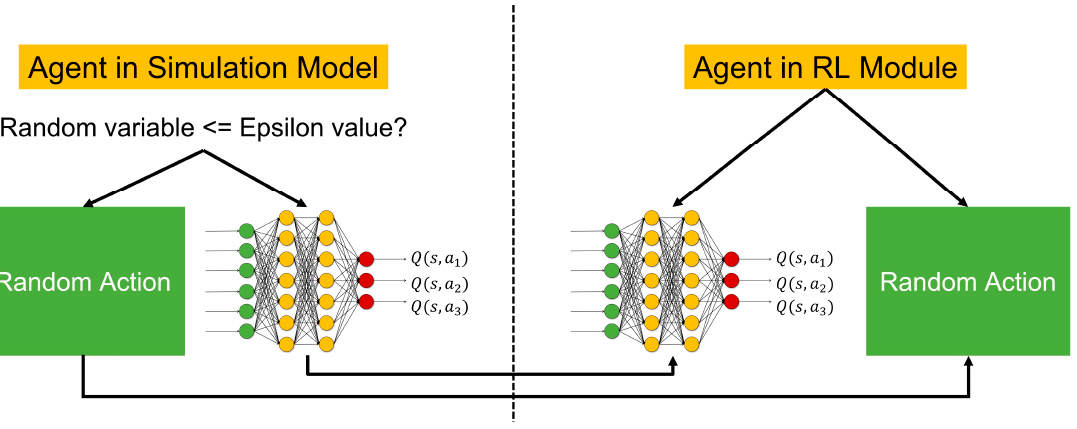
Figure 6. Replication of neural network between simulation model and